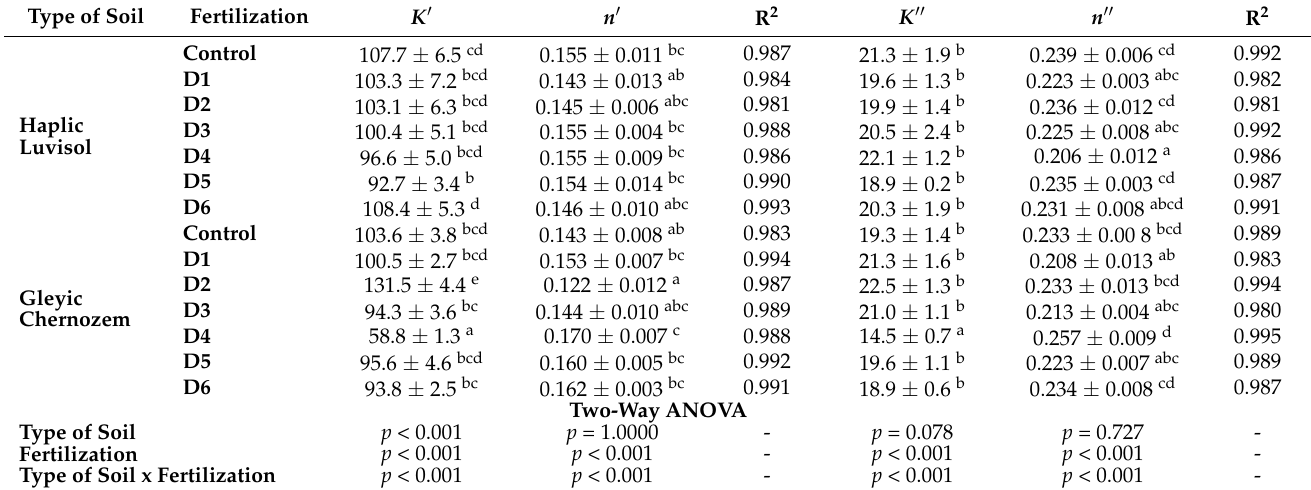
Table 6. Parameters of power law equations describing viscoelastic properties of potato starch